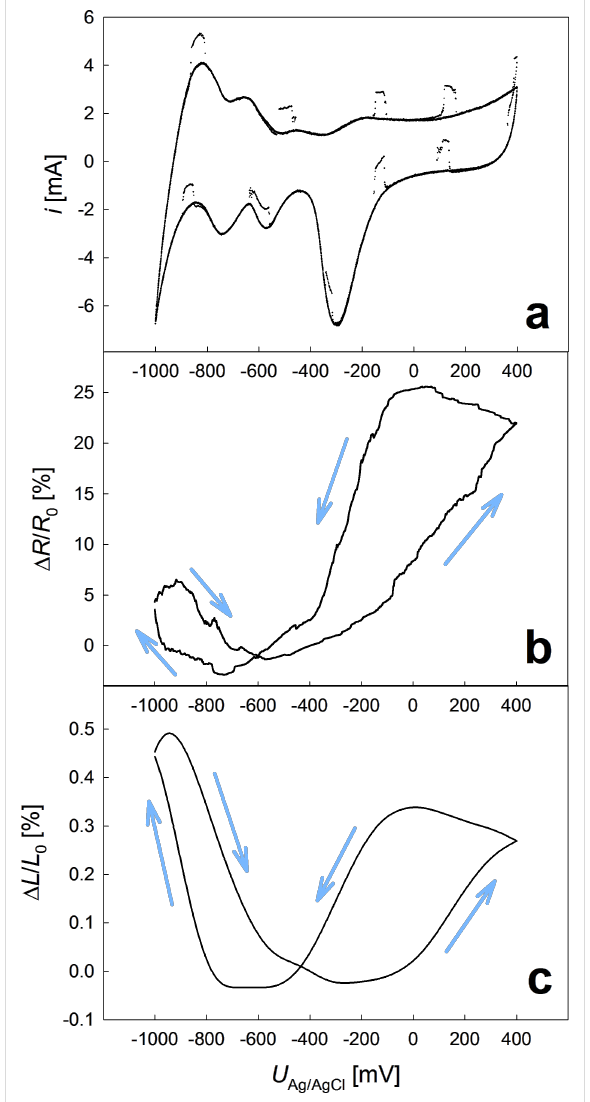
Figure 1: Cyclic voltammetry of np-Pd with a scan rate of 1 mV/s, re- corded between potentials U Ag/AgCl of − 1000 mV and +400 mV (a) with concommitant relative variations in electrical resistance (b) and sam- ple thickness